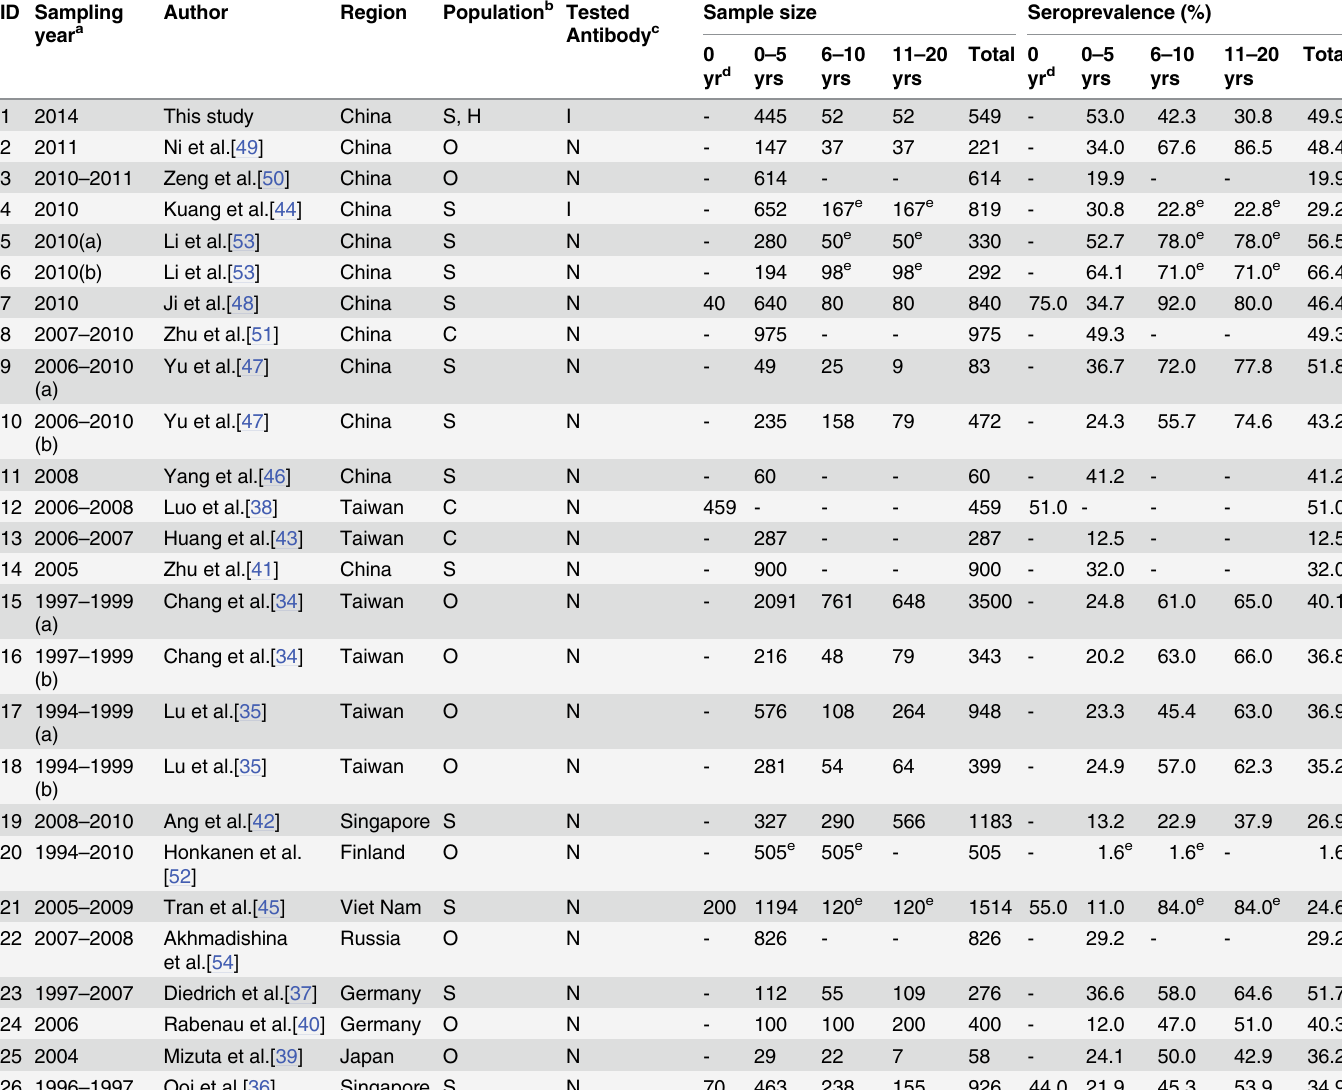
Table 3. Summary of the EV71 seroprevalence studies in healthy children since